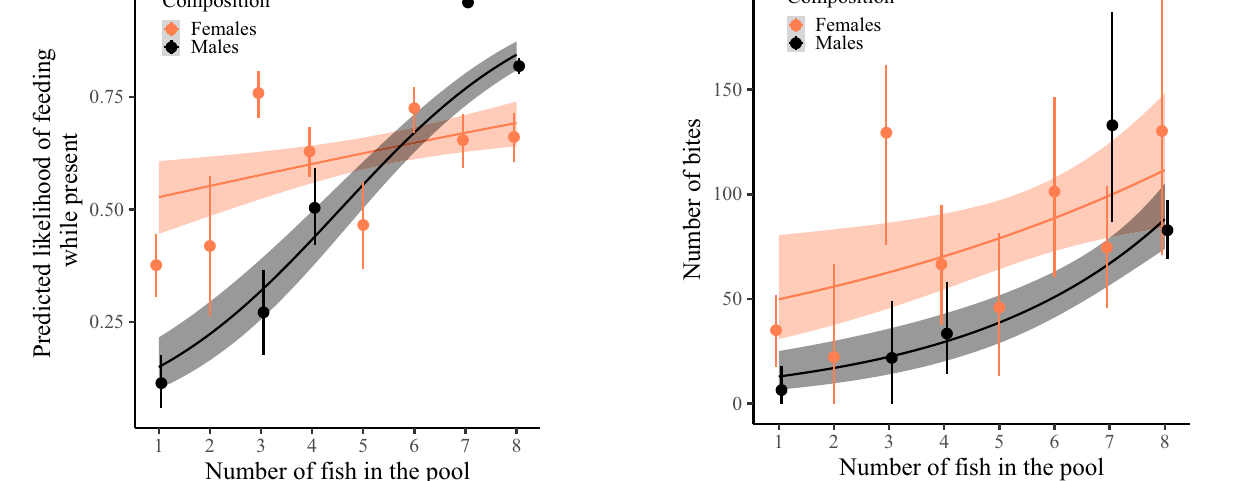
Fig. 3 Predicted probability of feeding when at a food patch as a function of the number of fi sh in the pool. Dots with bars represent the mean ± 95% con fi dence interval (CI) predicted value summary statistics for each sex (female/male = orange/black) and fi sh number (CI obtained from 1000 bootstraps). Grouping of the data was conducted for graphical purposes only; analyses were conducted on an individual-by-trial level ( n = 1423) with the number of fi sh in the pool as a continuous variable (Table 3). Note that there were no batches with two, fi ve or six males (Supplementary Table 2). Regression lines show the predicted fi nal model values. Shaded areas around the lines re fl ect 95% CI. A slight horizontal position dodge was added to reduce overlap.